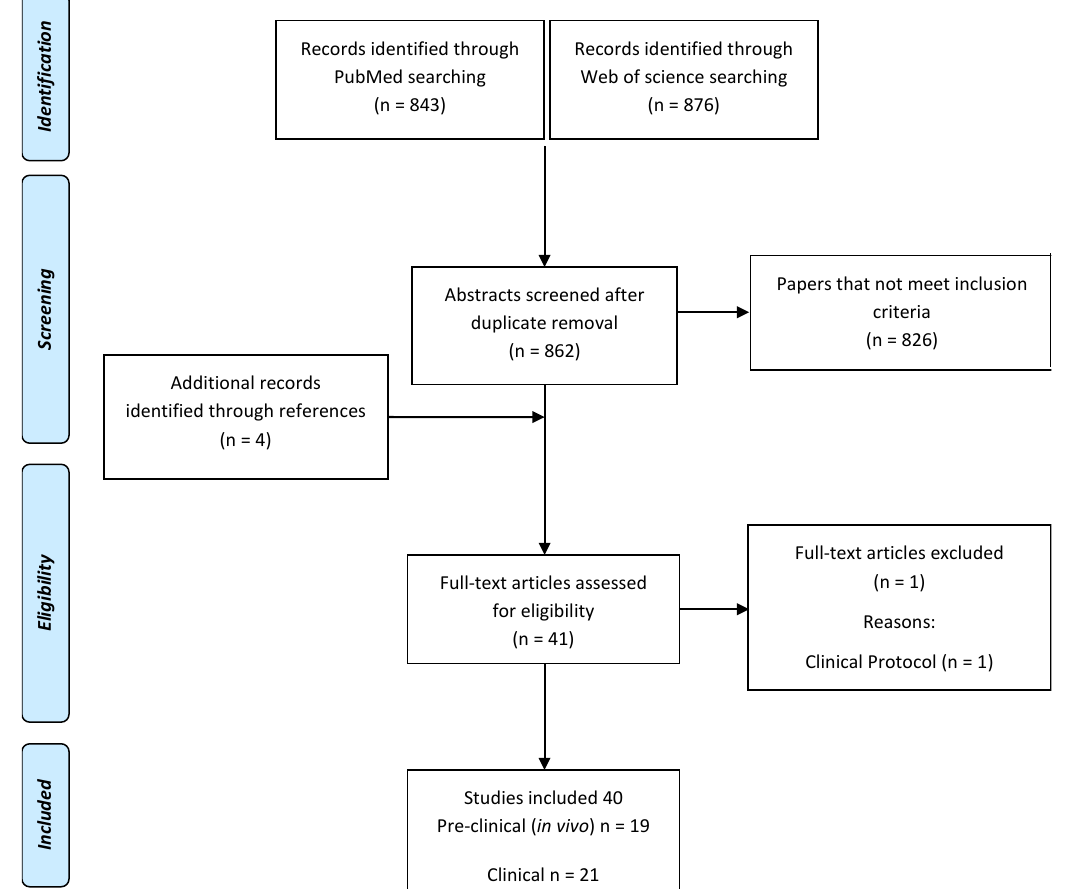
Figure 2. Flowchart of literature search.